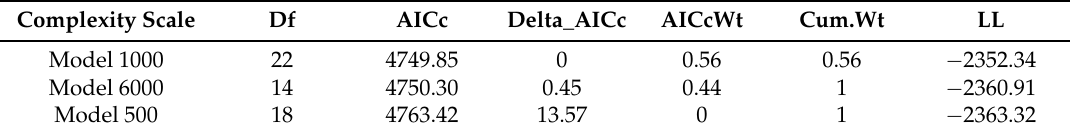
Table 3. Comparison of the three simplest models for taxonomic richness. Df: degrees of freedom of the model; AICc: corrected Akaike information criterion; Delta AICc: difference in AICc between the model and the model with the smallest AICc; AICcWt: model weight according to delta AICc; Cum. Wt: cumulative model weights; LL: Log Likelihood.